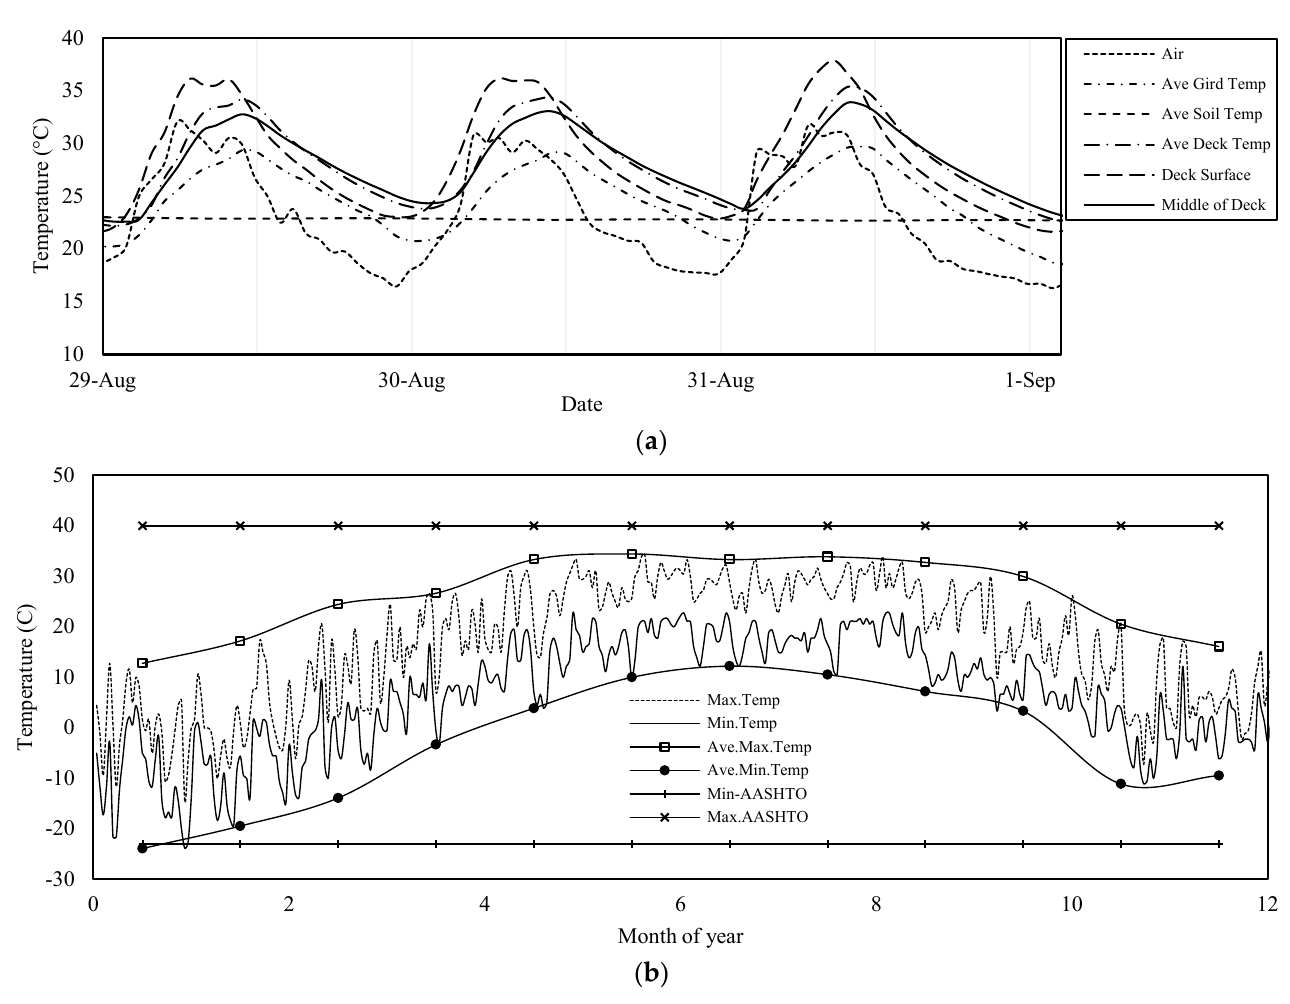
Figure 7. Measured temperatures ( a ) warm weather temperature variation ( b ) daily temperature data.